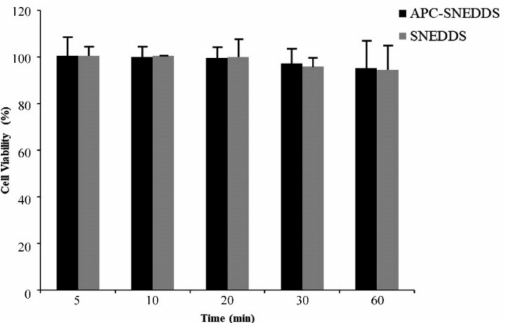
Figure 8. Viability of fibroblast cells from the human periodontal ligament after exposure to APC SNEDDS (black columns) and the blank SNEDDS (grey